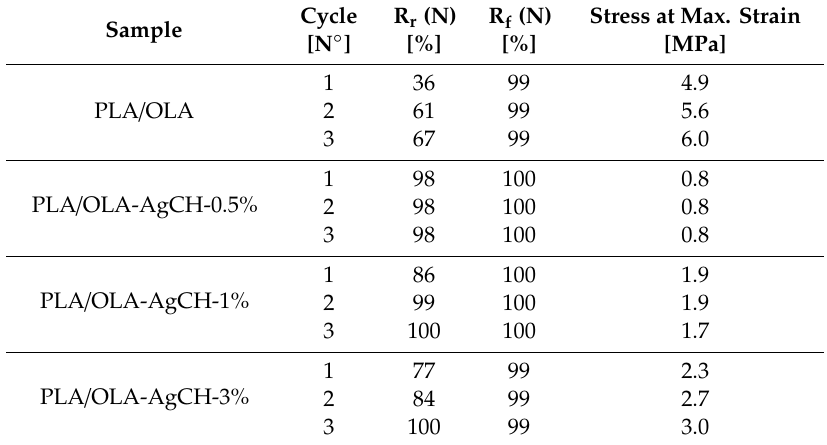
Table 3. Strain recovery, strain fixity and stress at maximum strain values for each shape memory cycle. Sample